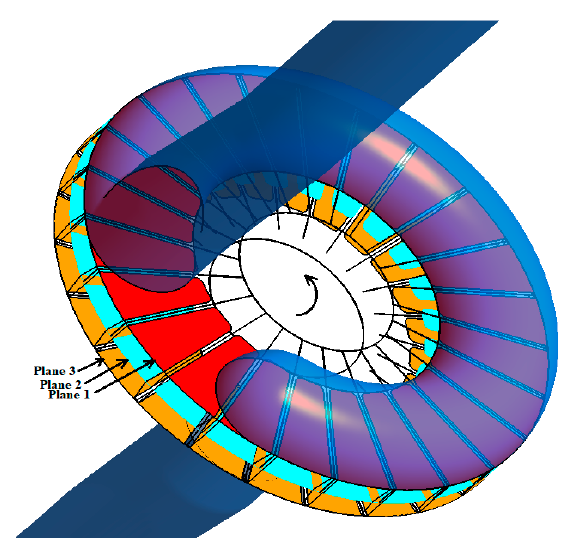
Figure 6. Three axial planes on the impeller flow passage.